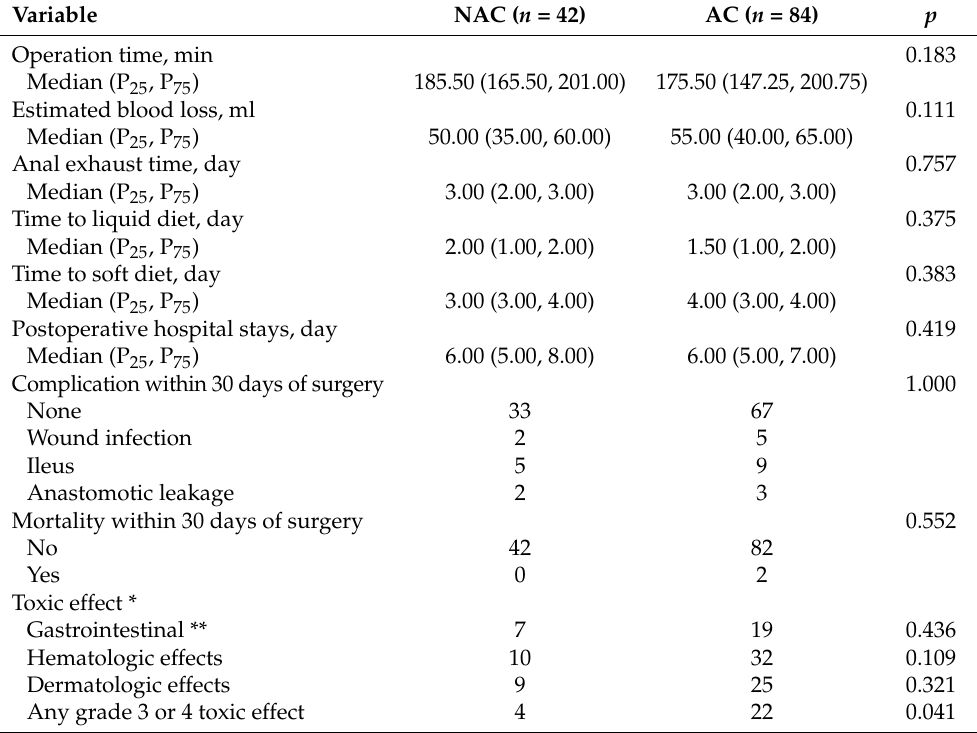
Table 3. Comparison of perioperative outcomes between NAC and AC